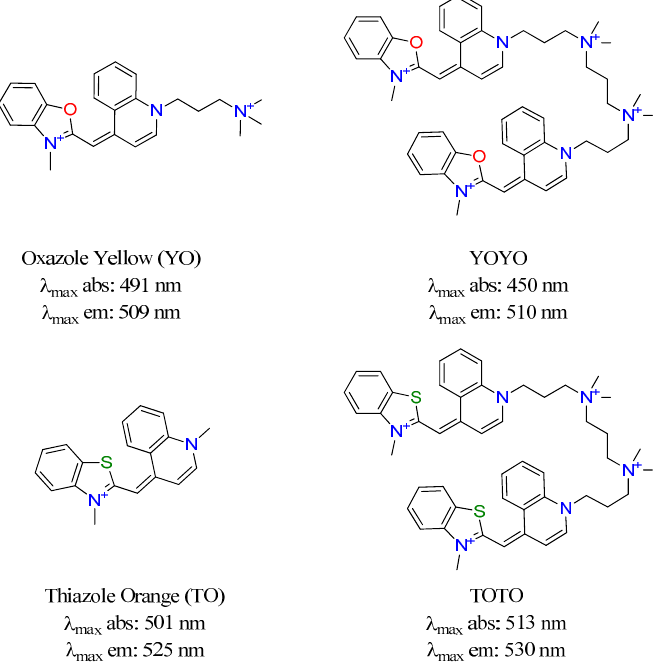
Figure 1. Commercially available asymmetric monomethine cyanine dyes.